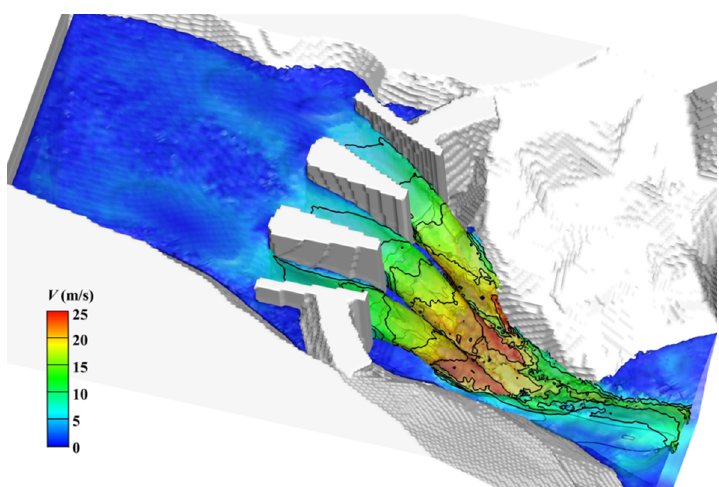
Figure 9. The geometry of flood discharge of an arch dam.